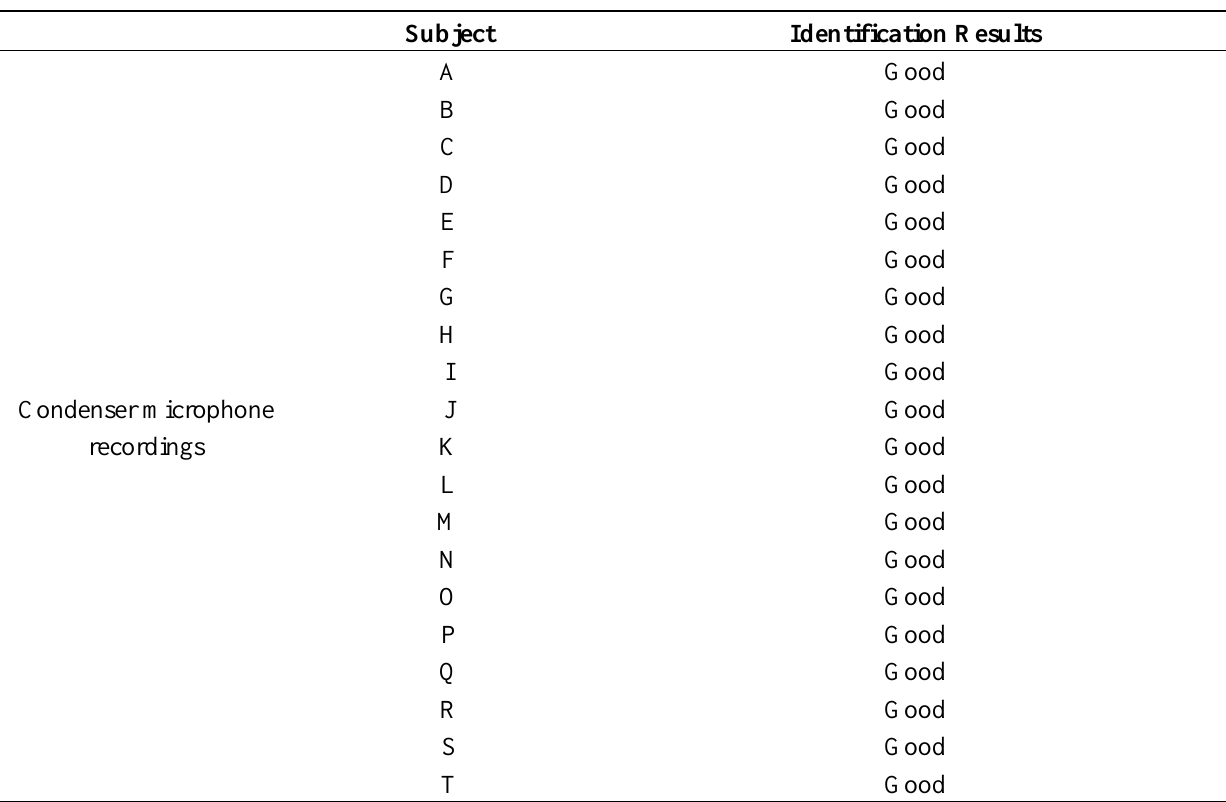
Table 11. Analysis results of the current proposed